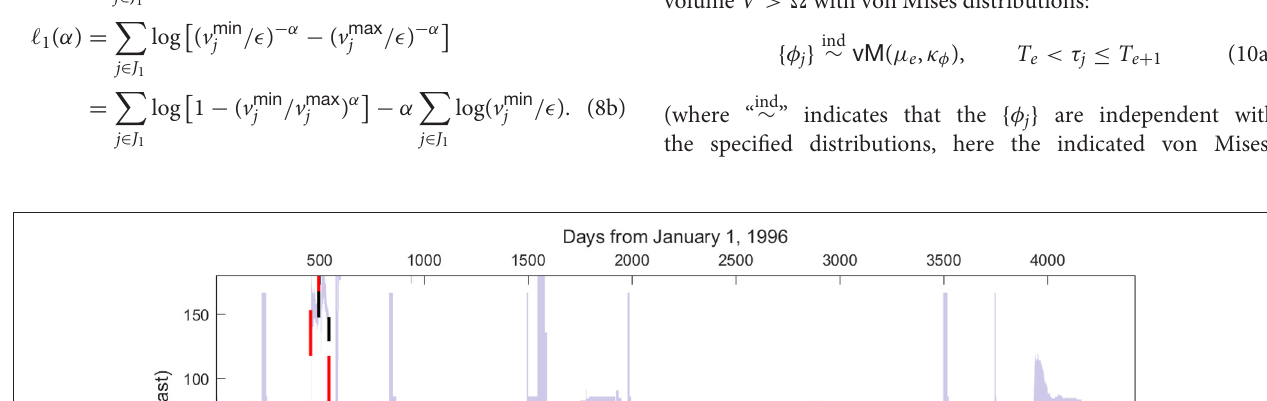
1 ], based only on data in interval ( T e , τ ]. Predictive +